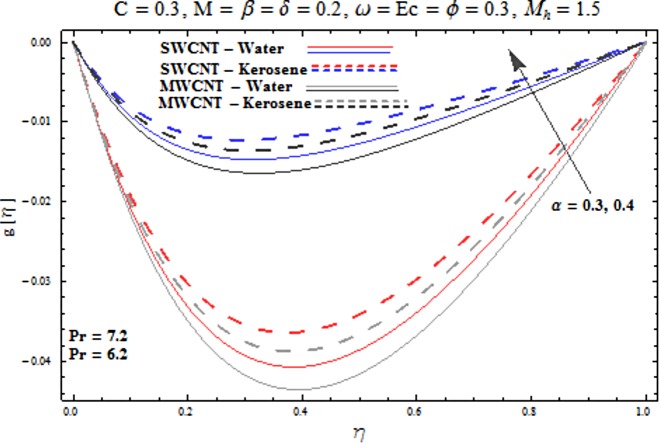
Effect of α on g′.